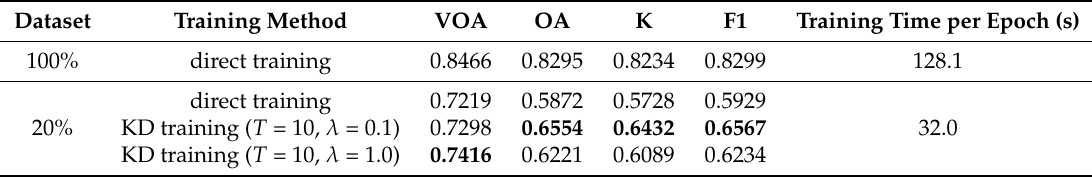
Table 4. Results of training the student model on part of AID